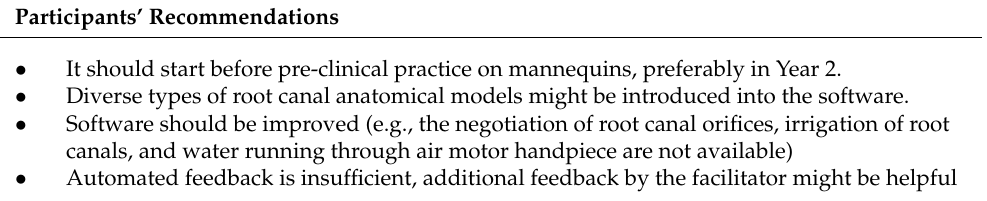
Table 4. Recommendations for Future Development of Virtual Reality Dental Simulation in Endo- dontics.